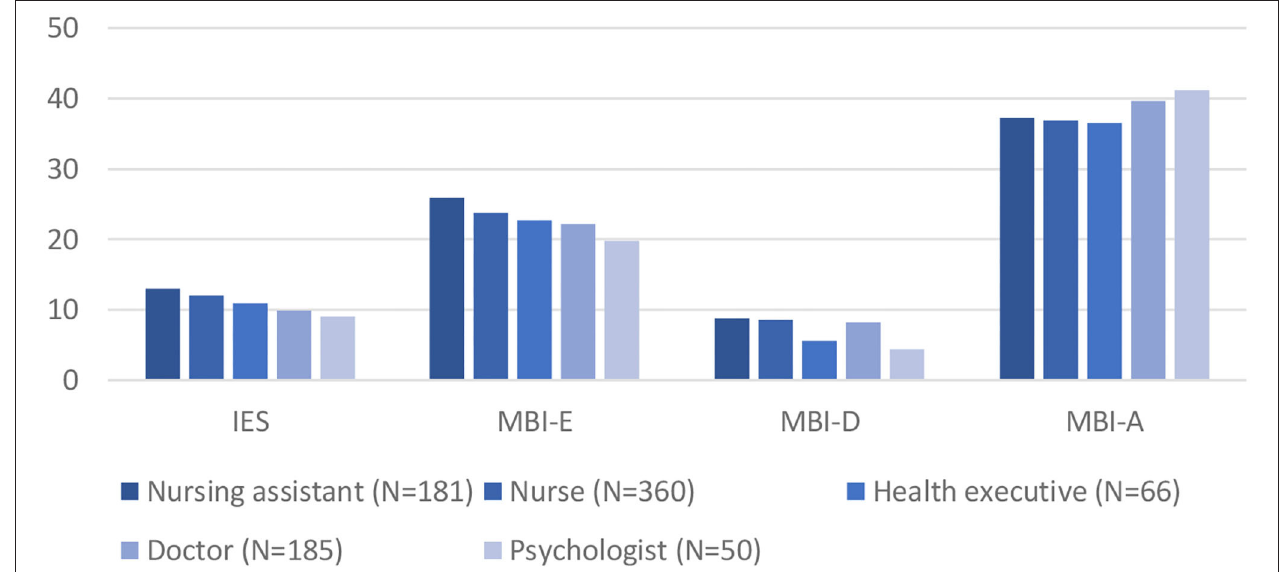
FIGURE 2 | Emotional difficulties depending on the job position. MBI-E, Maslach Burnout Inventory-Exhaustion; MBI-D, Maslach Burnout Inventory-Depersonalization; MBI-A, Maslach Burnout Inventory-Accomplishment.